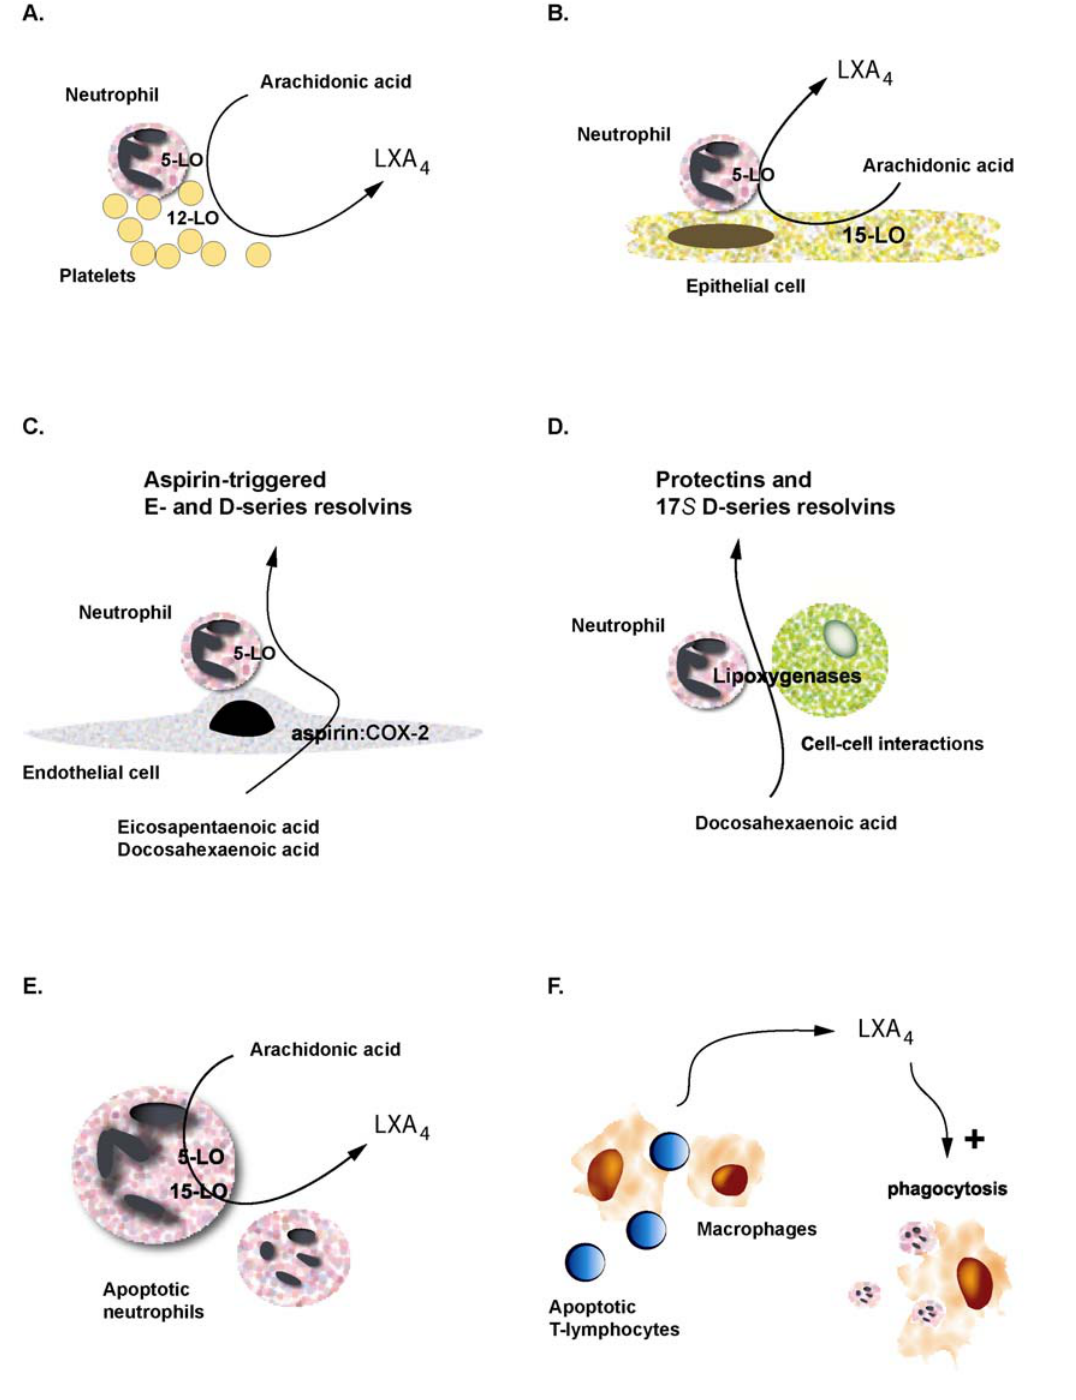
FIGURE 5. Generation and actions of anti-inflammatory/proresolution lipid mediators during acute inflammation and resolution. The formation of anti-inflammatory and pro-resolution lipid mediators is characterized by heterotypic cellular interactions that bring together the required fatty acid oxygenases permitting transcellular biosynthesis. (A) Biosynthesis of LXA 4 by transformation of AA via oxygenation by neutrophil 5-LO and platelet 12-LO. (B) Biosynthesis of LXA 4 by transformation of AA via sequential oxygenation by epithelial cell 15-LO and neutrophil 5-LO. (C) Formation of aspirin-triggered E- and D-series resolvins from the ω -3 PUFA EPA and DHA. (D) Formation of protectins and D-series resolvins from DHA via sequential oxygenation steps involving neutrophil lipoxygenases and other inflammatory cells lipoxygenases. (E) Formation of LXA 4 by apoptotic neutrophils expressing both 5- and 15-LO[106]. (F) Formation of LXA 4 by macrophages that are exposed to apoptotic lymphocytes[29]. The formed LXA 4 contributes to the nonphlogistic nature of apoptotic cell removal by phagocytosis, and LXA 4 itself can stimulate the phagocytosis of apoptotic